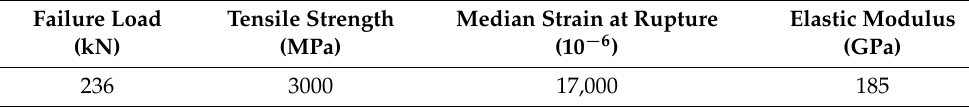
Table 2. Physical properties of 10-mm FRP tendon.